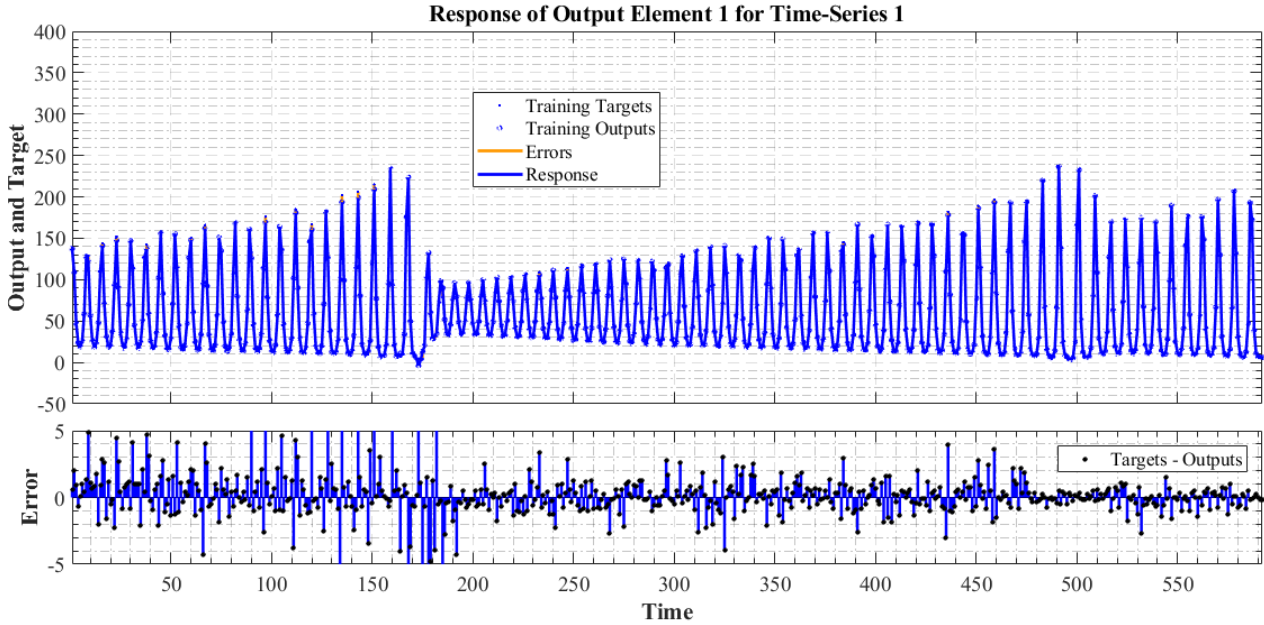
Figure 4. Time series response of training the created HNN